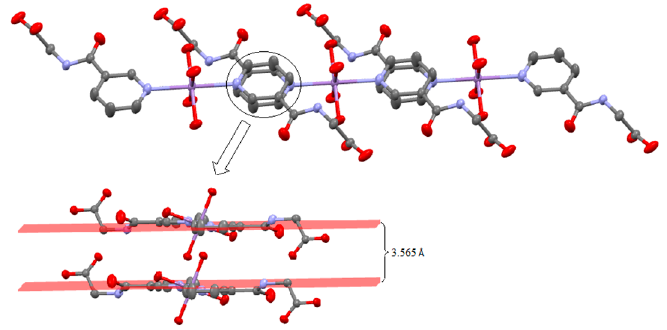
Figure 3. The π - π stacking interactions of 1 .